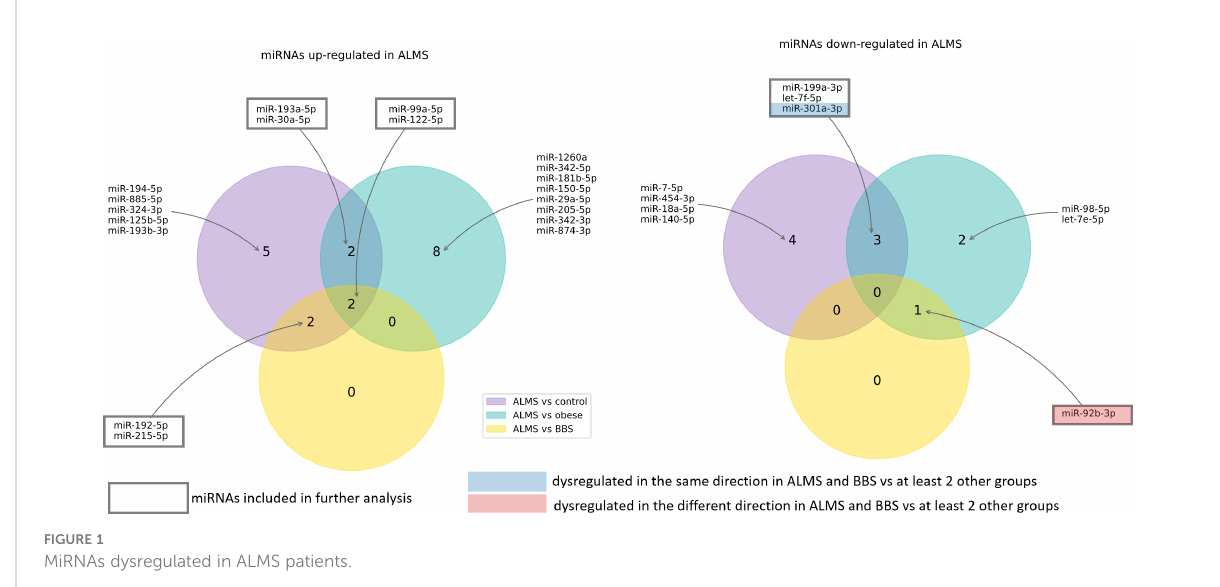
FIGURE 1 MiRNAs dysregulated in ALMS